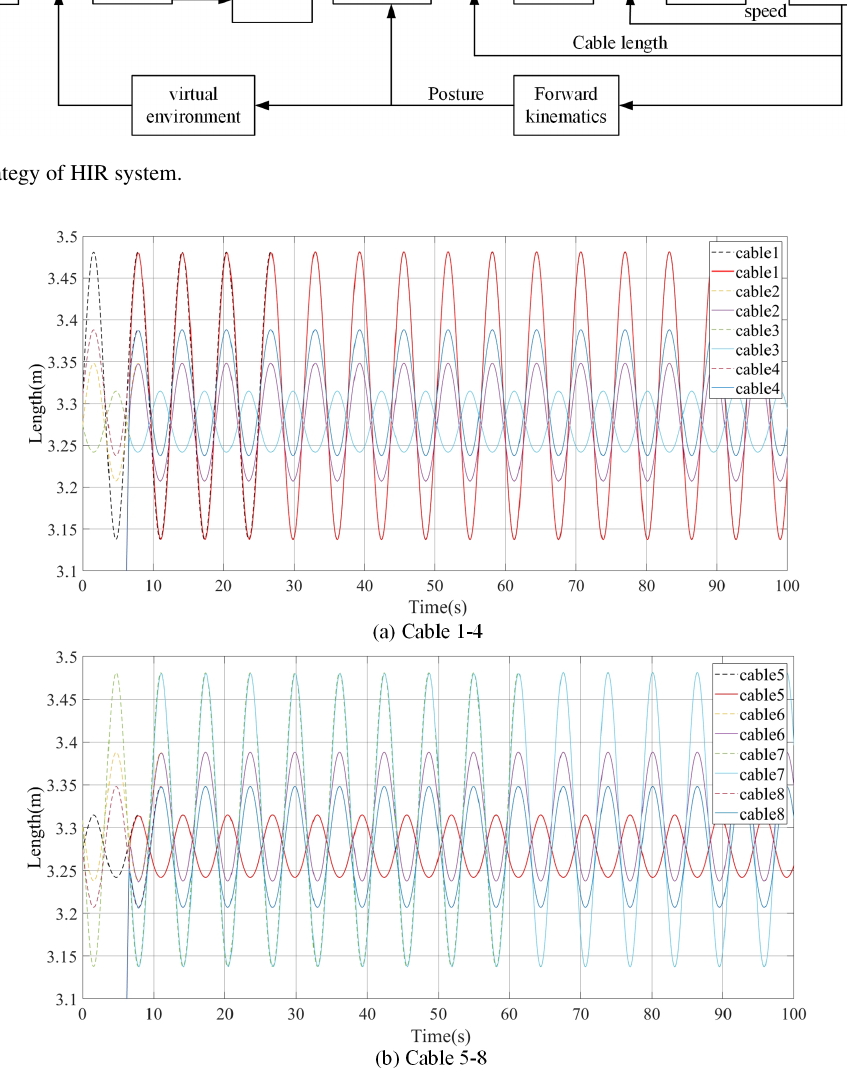
Figure 19. Subsequent condition of each cable in space track completed by HIR.